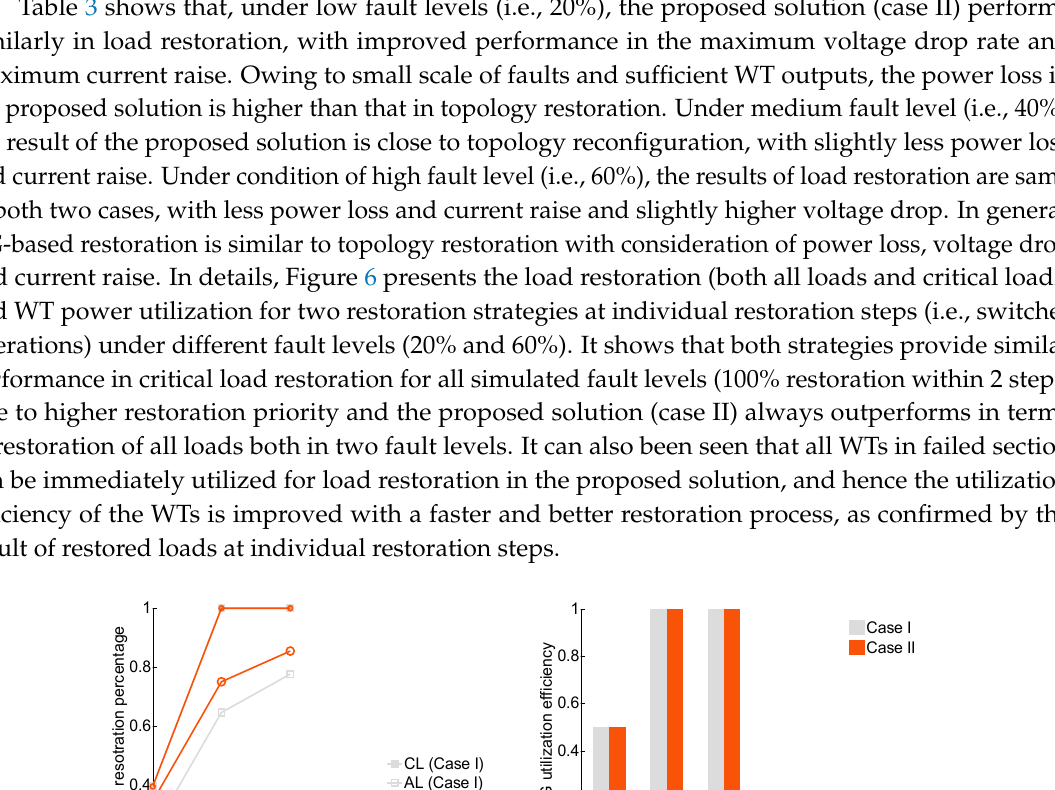
Table 3. Performance of restoration under faults at multiple buses.